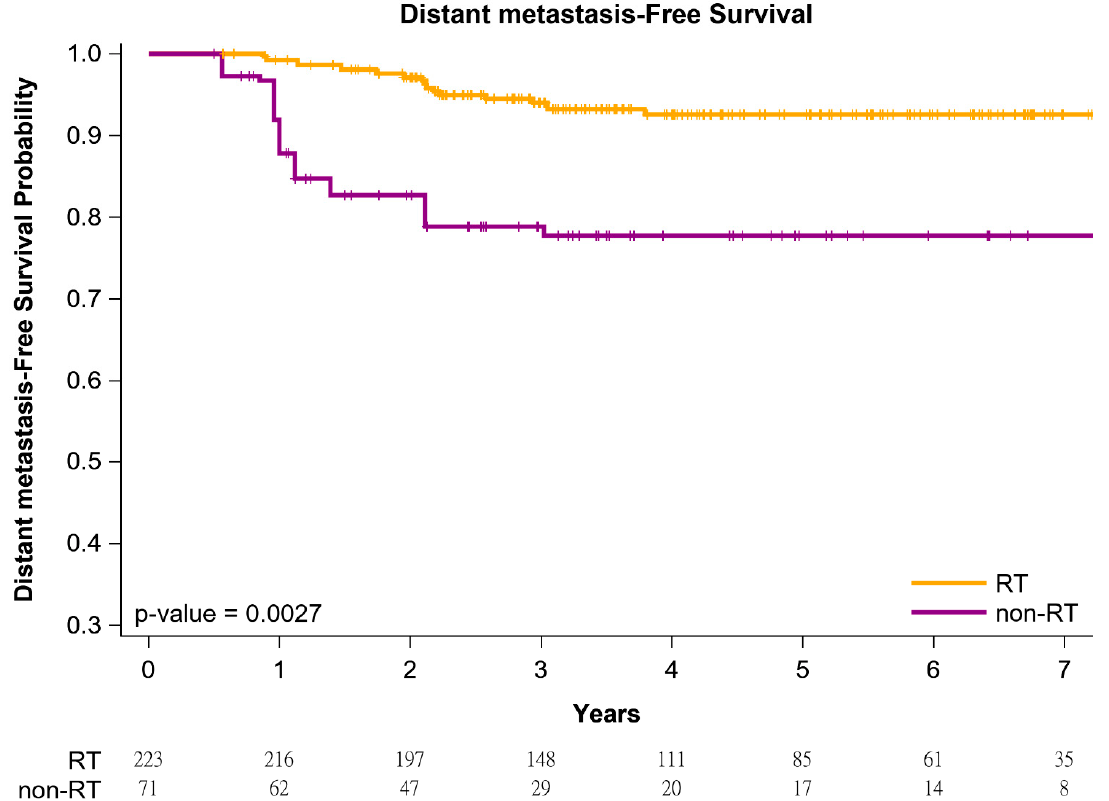
Figure 3. Kaplan–Meier distant metastasis–free survival curves of propensity score–weighted population with breast cancer and heart failure with reduced ejection fraction receiving breast conservative surgery.